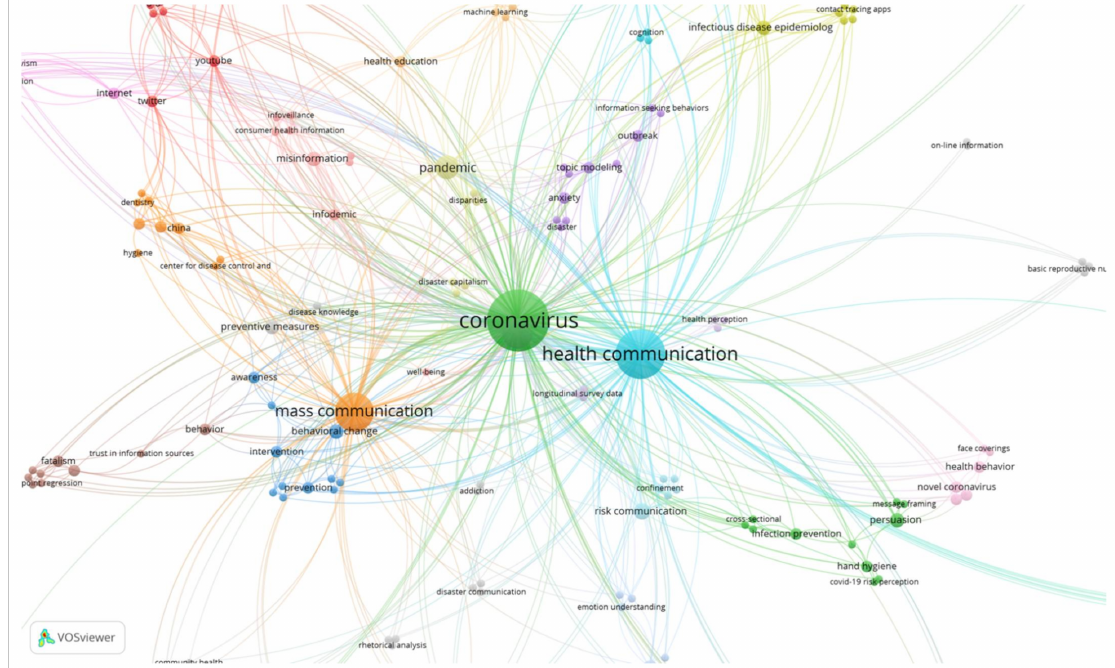
Figure 6. Map of keywords and their confluence in articles published in 2020.